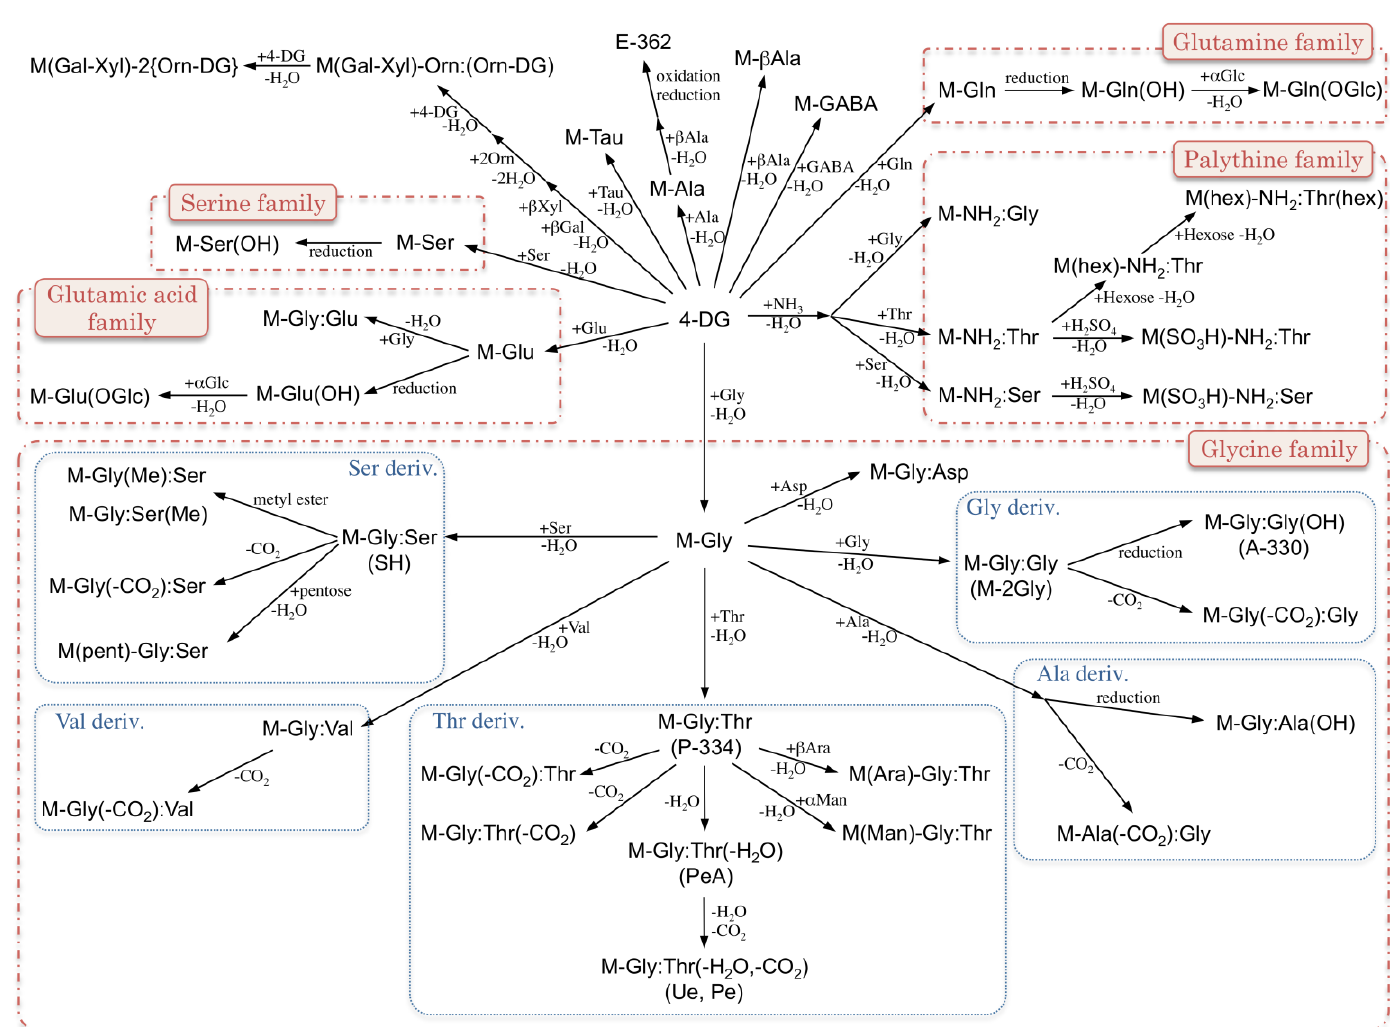
Figure 1. Structural relationships of various mycosporine-like amino acids (MAAs). Note that ammonia is not used for MAA biosynthesis due to its toxicity; however, it is useful to simplify the figure by explaining the structural relationships of various types of